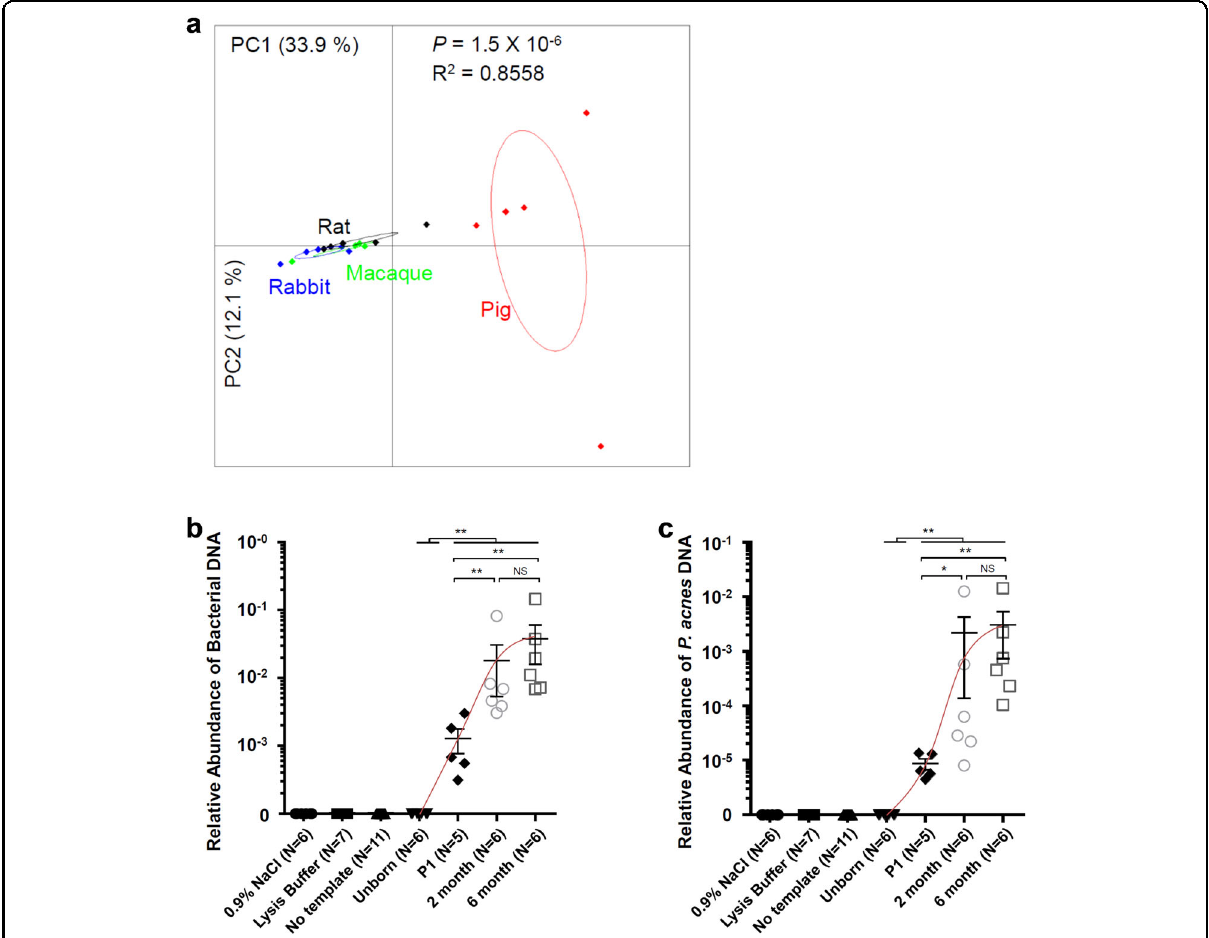
Fig. 5 The intraocular metagenome in the eyes of rabbit, rat, macaque, and pig analyzed using PCoA. a The PCoA of intraocular metagenomes in four mammals. The Bray Curtis distance was used and P value was calculated using PERMANOVA test. b The abundance of bacterial DNA in rat intraocular fl uids was measured using real-time PCR assays of total 16S rDNA and represented as the relative abundance to the level of rat Actb gene. c The abundance of P. acnes DNA in rat intraocular fl uids was measured using real-time PCR assays of P. acnes 16S rDNA and represented as the relative abundance to the level of rat Actb gene. The error bar represents the mean ± SEM. The statistical difference was measured using Mann- Whitney U test and the signi fi cance levels are denoted by asterisks (* P < 0.05, ** P < 0.01, NS: not signi fi